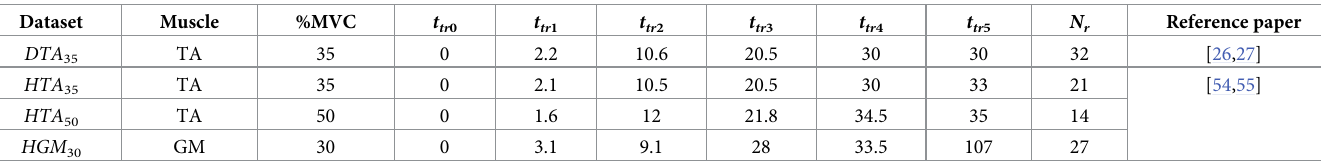
Table 1. The four experimental datasets processed in this study. N r spike trains are identified per dataset during trapezoidal contractions of the Tibialis Anterior (TA) or Gastrocnemius Medialis (GM) muscles. The trapezoidal force trace is described by times t